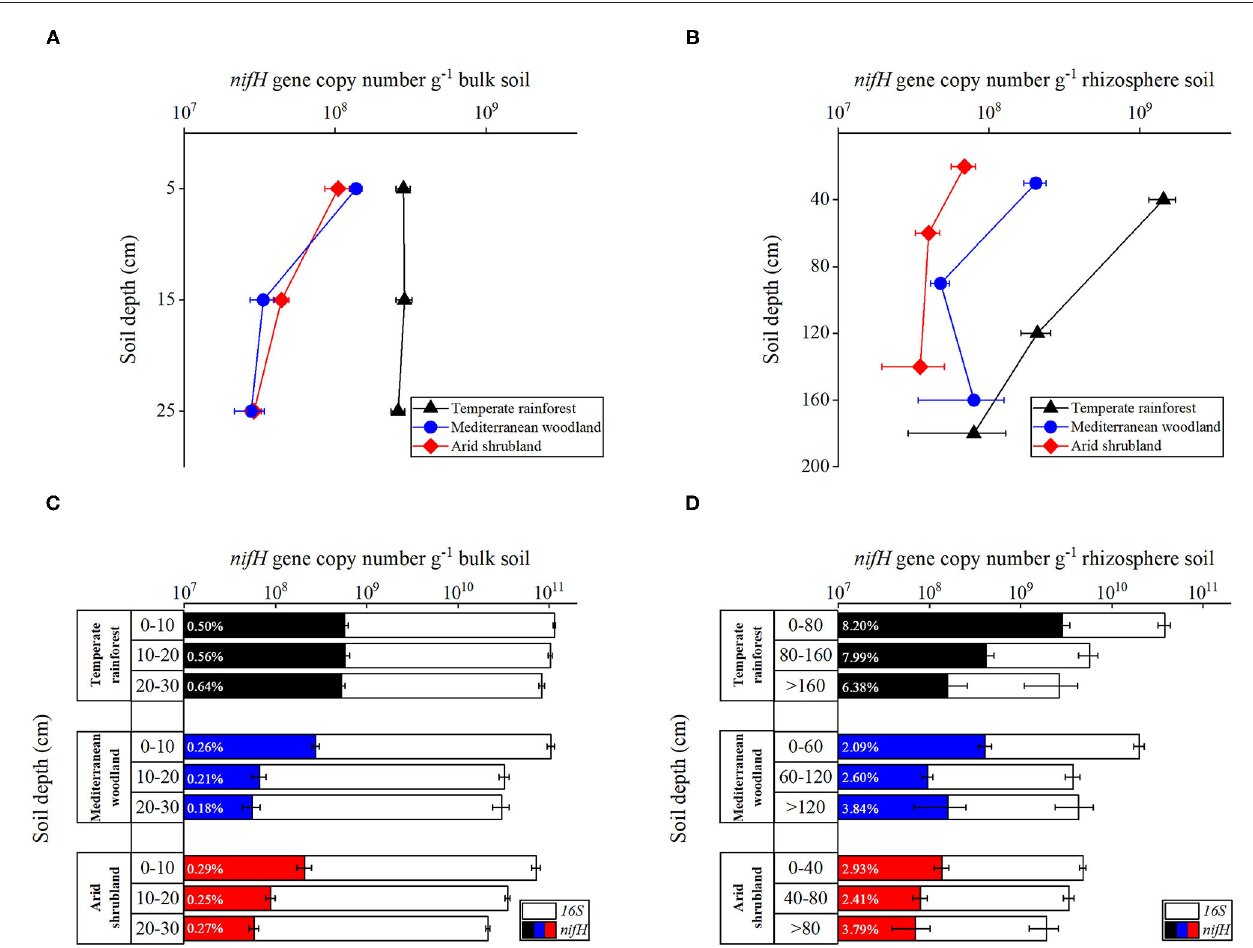
FIGURE 5 | Abundance of nitrogenase reductase ( nifH ) gene (qPCR) depending on depths in temperate rainforest, Mediterranean, and arid soils. (A,C) nifH gene in bulk topsoil, (B,D) nifH gene in the rhizosphere of the complete profile down to the saprolite. Abundance of nifH gene is expressed in gene copy number (A,B) and percentage of diazotrophy in prokaryotic parts of community (C,D) . Data are expressed as gene copy number per gram soil and represent means of four biological replicates, with three technical replicates for every biological replicate. Error bars represent standard errors of the